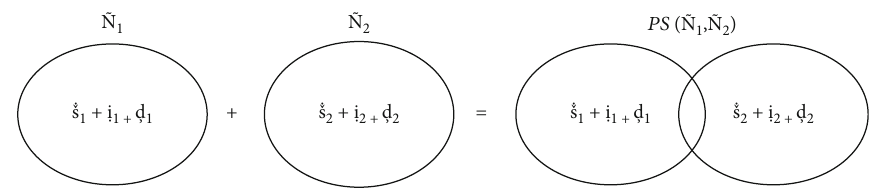
Figure 1: The geometric interpretation of PS